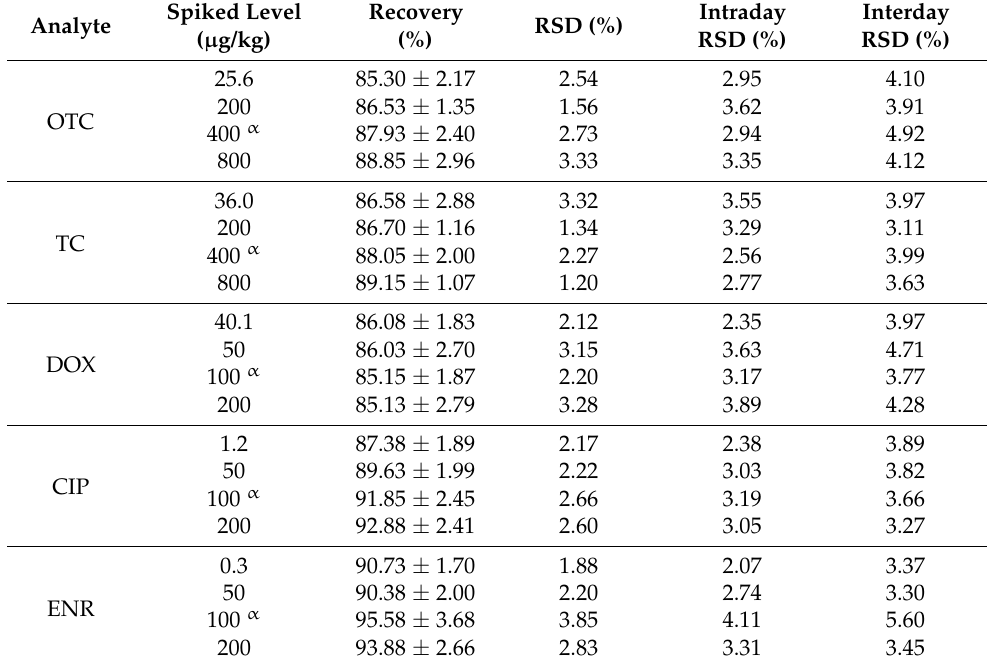
Table 4. Recovery and precision for analyses of blank chicken yolk spiked with OTC, TC, DOX, CIP and ENR (n = 6).